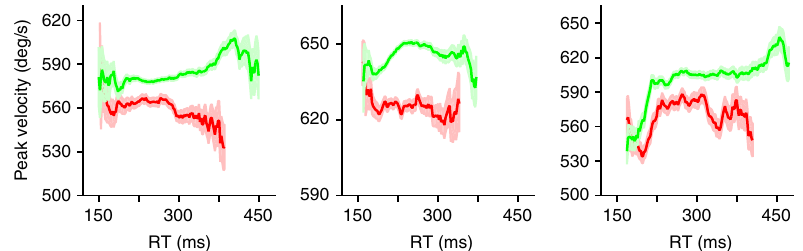
Fig. 4 Peak velocity is largely independent from movement preparation time in the CS task. Mean peak velocity (±1 s.e.m.) of correct (green) and incorrect (red) saccadic choices as a function of RT. Data are from monkeys R, T, and G (left to right)